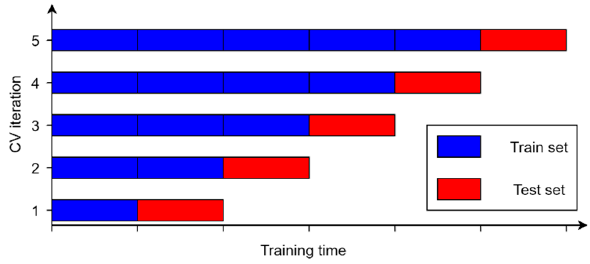
Figure 5. Example of a searching grid for two parameters.